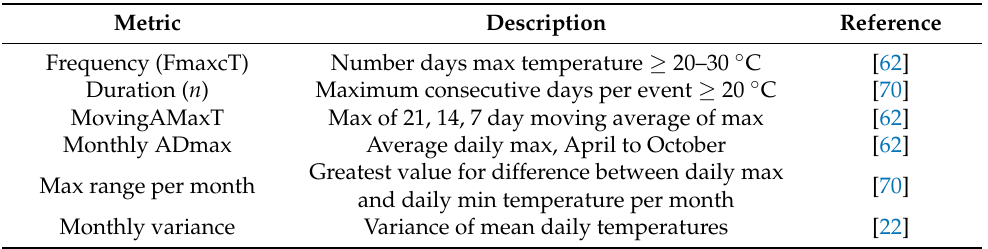
Table 3. Water temperature metrics to quantify frequency and duration of exceedance, magnitude of change, and